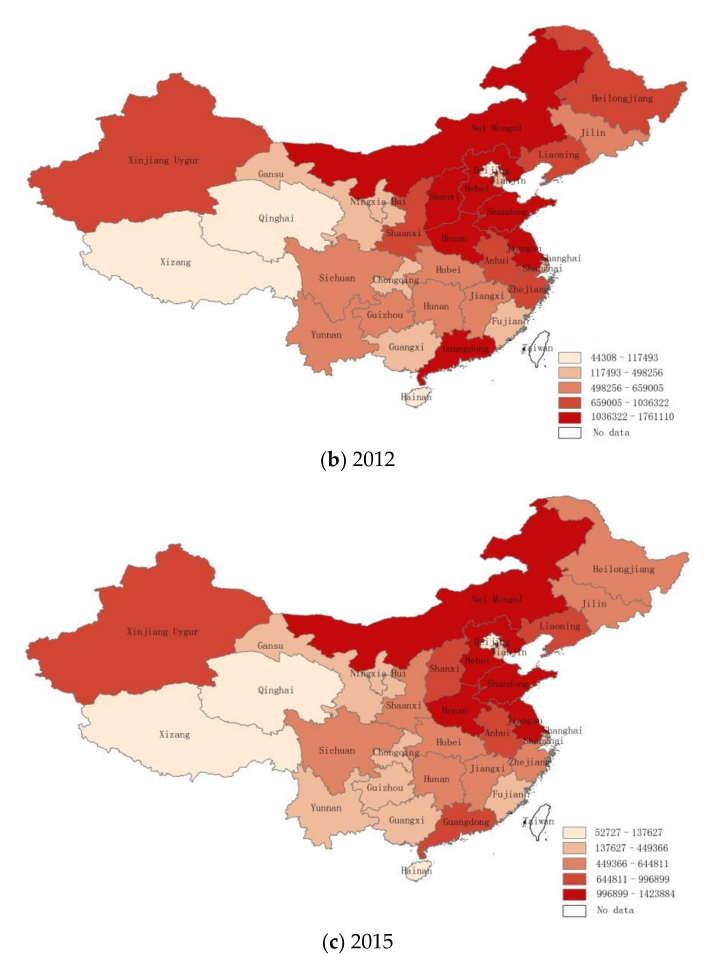
Figure 1. China’s NO x emissions distribution in ( a ) 2010, ( b ) 2012, and ( c ) 2015, respectively (Units: